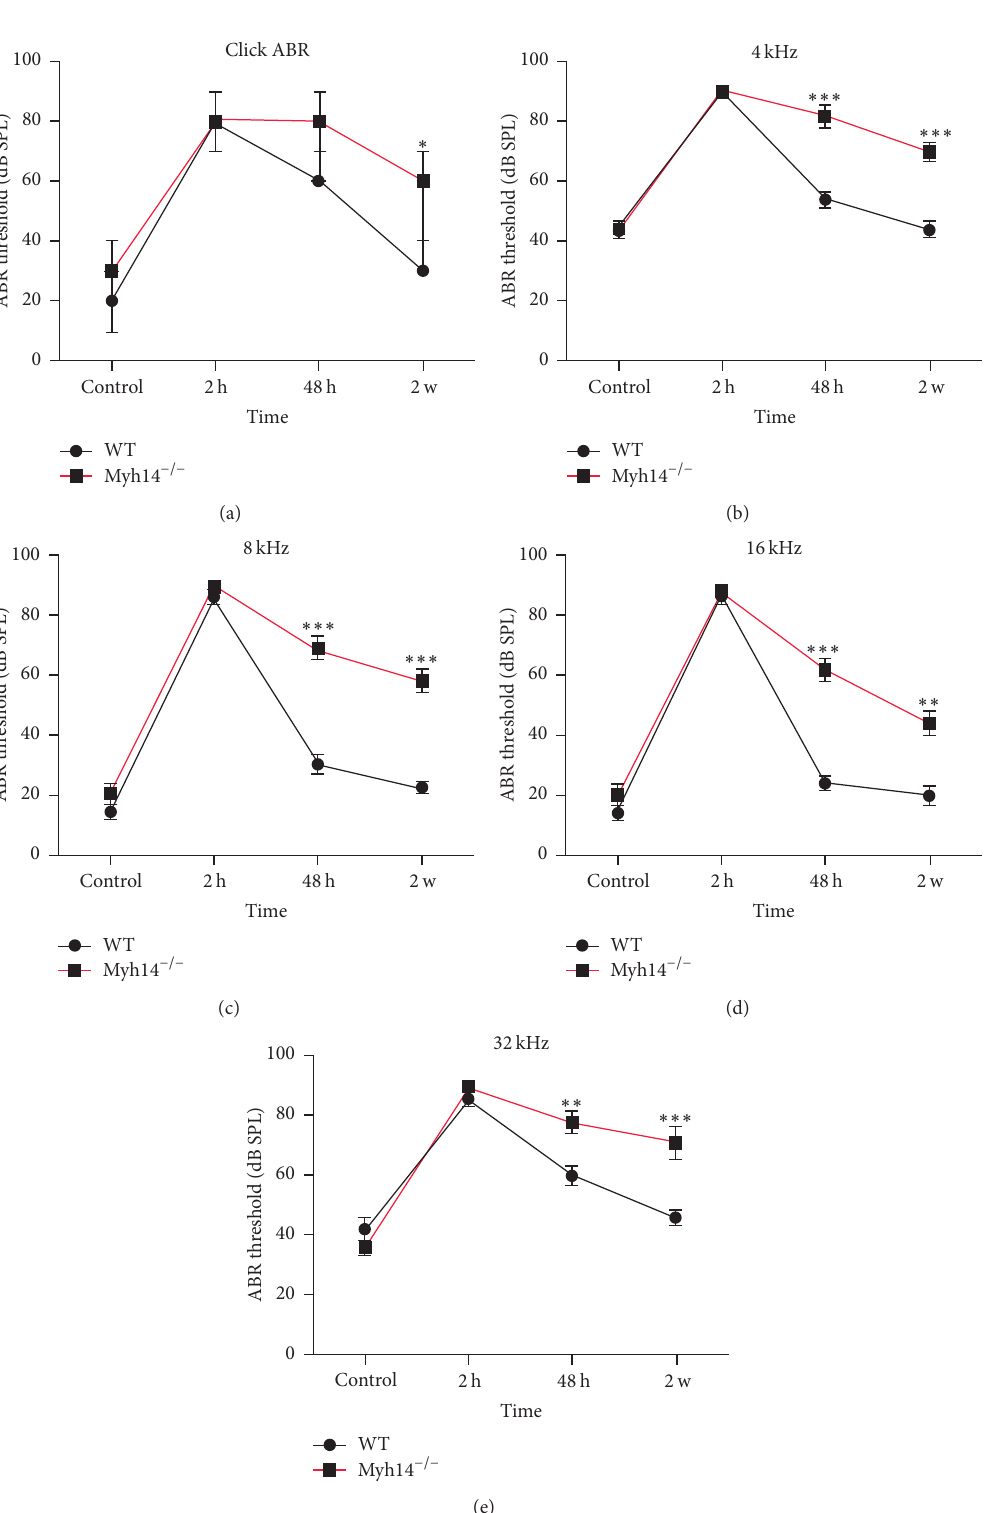
Figure 8: ABR threshold shifts following noise exposure between Myh14 −/− mice and controls. The ABR threshold shift was tested on Myh14 −/− mice and controls before noise exposure and 2 h, 48 h, and 2 weeks after noise exposure ( 𝑛 = 8 for each group). ∗ 𝑃 < 0.05 compared to the controls. ∗∗ 𝑃 < 0.01 by Student’s 𝑡 -test. ∗∗∗ 𝑃 < 0.001 by Student’s 𝑡 -test compared to the control group. ABR measurements were